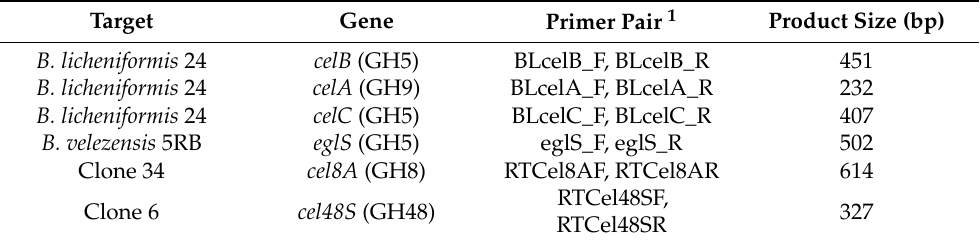
Table 2. The detected cellulase genes, specific primer pairs for its determination, and the size of RT-PCR expected products.